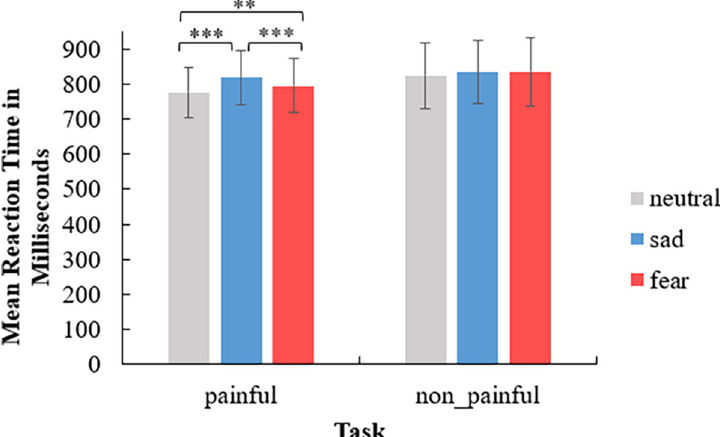
Fig 2. Behavioral results under six experimental conditions. The error bars representing standard errors of the mean. The symbol of “ �� ” means p < .01. “ ��� ” means p � .001.